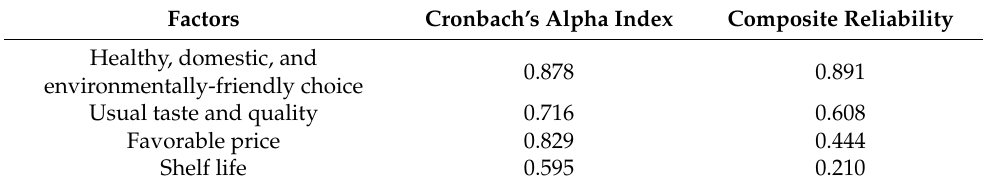
Table 6. Reliability of the measuring instrument. Factors Cronbach’s Alpha Index Composite Reliability Healthy, domestic, and 0.878 0.891 environmentally-friendly choice Usual taste and quality 0.716 0.608 Favorable price 0.829 0.444 Shelf life 0.595